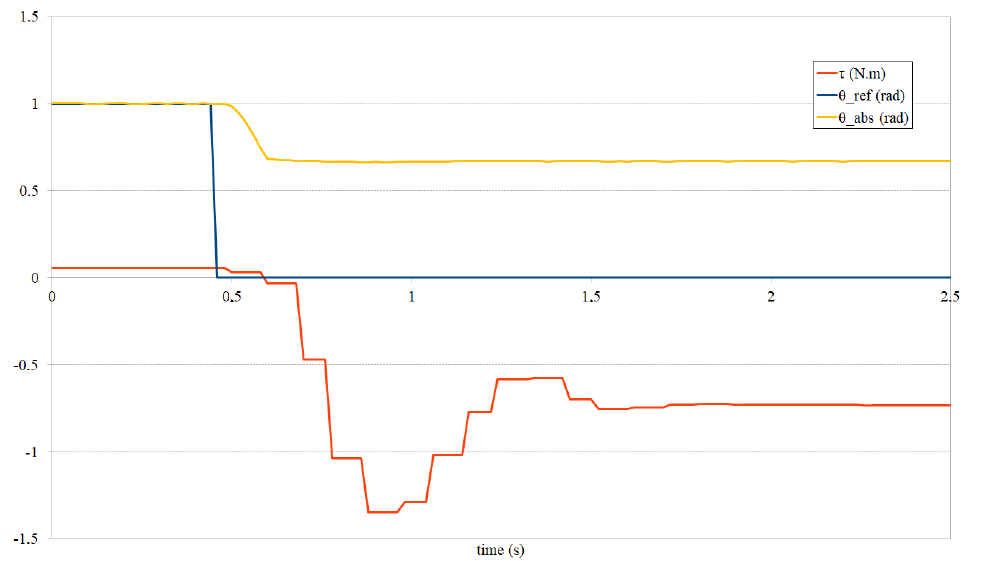
Figure 16. Change in position reference with compliant controller with obstacle in the